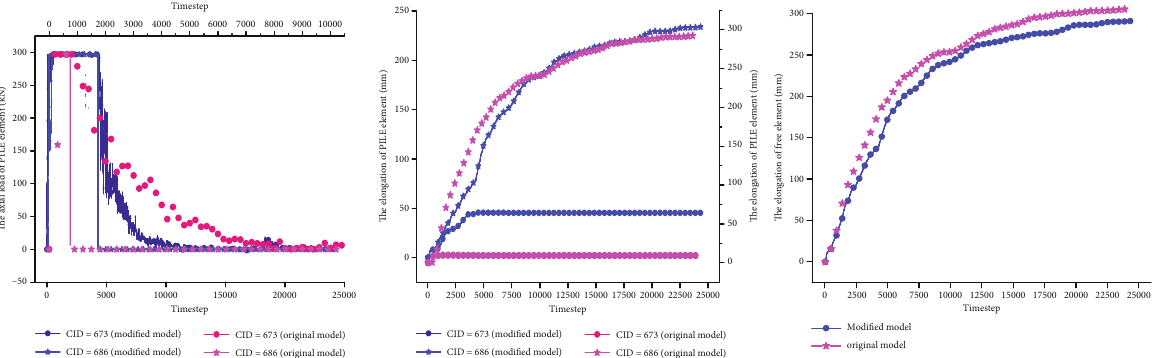
Figure 21: The relation curves of the axial load and elongation and the variation law of the elongation of the whole free section by the timestep under the two models (rock bolt